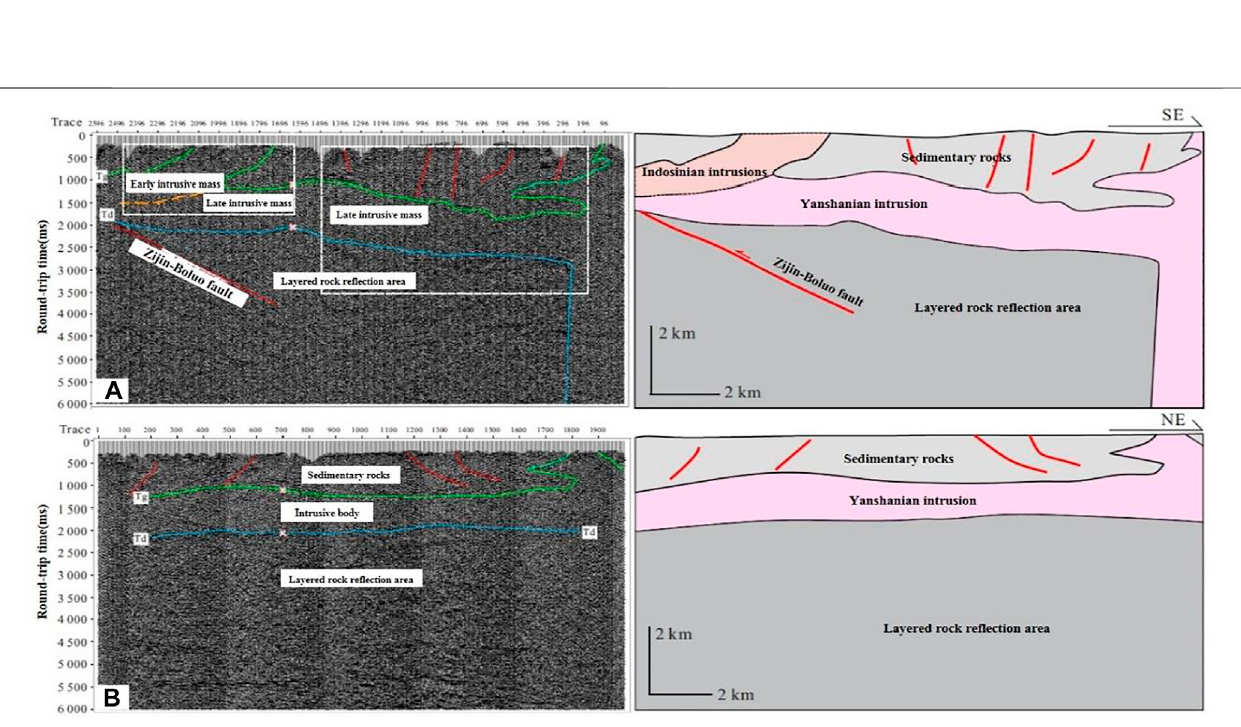
Frontiers in Earth Science |